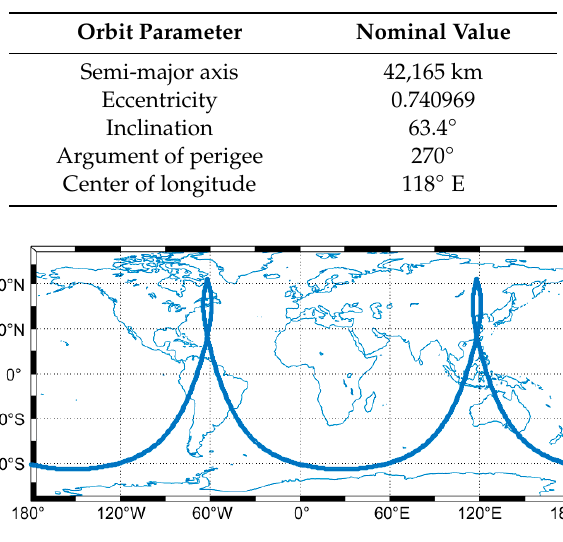
Figure 6. Ground track of highly eccentric orbits (HEO) satellites.